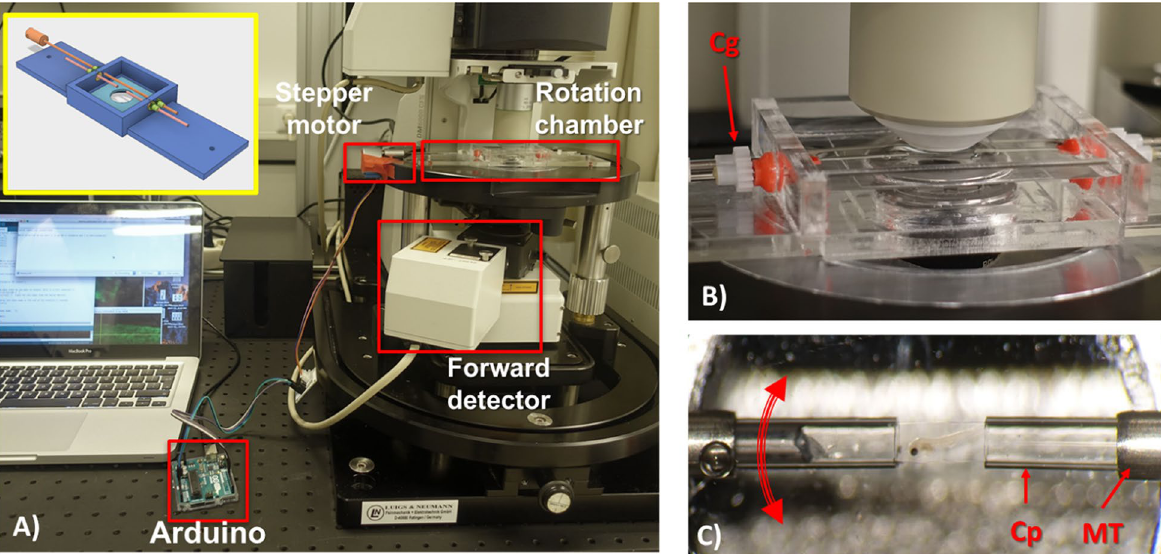
Figure 1. Rotation chamber for Multiview imaging with a two-photon microscope. ( A ) The rotation chamber mounted on the microscope stage is indicated. The stepper motor is attached to the shaft of the rotation chamber and is controlled by the Arduino board. On the inset of ( A ) the CAD design of the rotation chamber is shown. ( B ) The objective is focused on the sample in the rotation chamber. There is ample space for the objective to reach the sample. Below the chamber the condenser lens is positioned. The two cogs responsible for the rotation of the sample are indicated with Cg. ( C ) An image of the sample when it is ready for imaging. The sample is embedded in the agarose column and is extruded from the capillary allowing the objective to image the sample through the agarose layer. Red arrow indicates rotation direction. MT indicates the metallic tube, Cp indicates the haematocrit glass